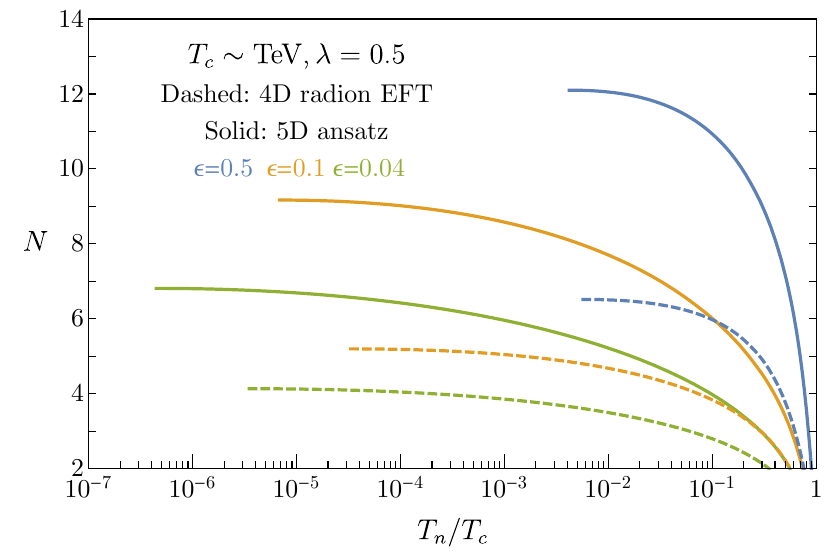
Figure 5. Nucleation temperature T n /T c (for fixed T c ∼ O (TeV) ) as a function of N for various (cid:15) for fixed λ = 0 . 5 . The solid lines denote the results using 5D ansatz, while the dashed lines use 4D radion EFT (upto two derivatives) to estimate the bounce. The end point of each curve shows the minimum T n and maximum N for a given parameter